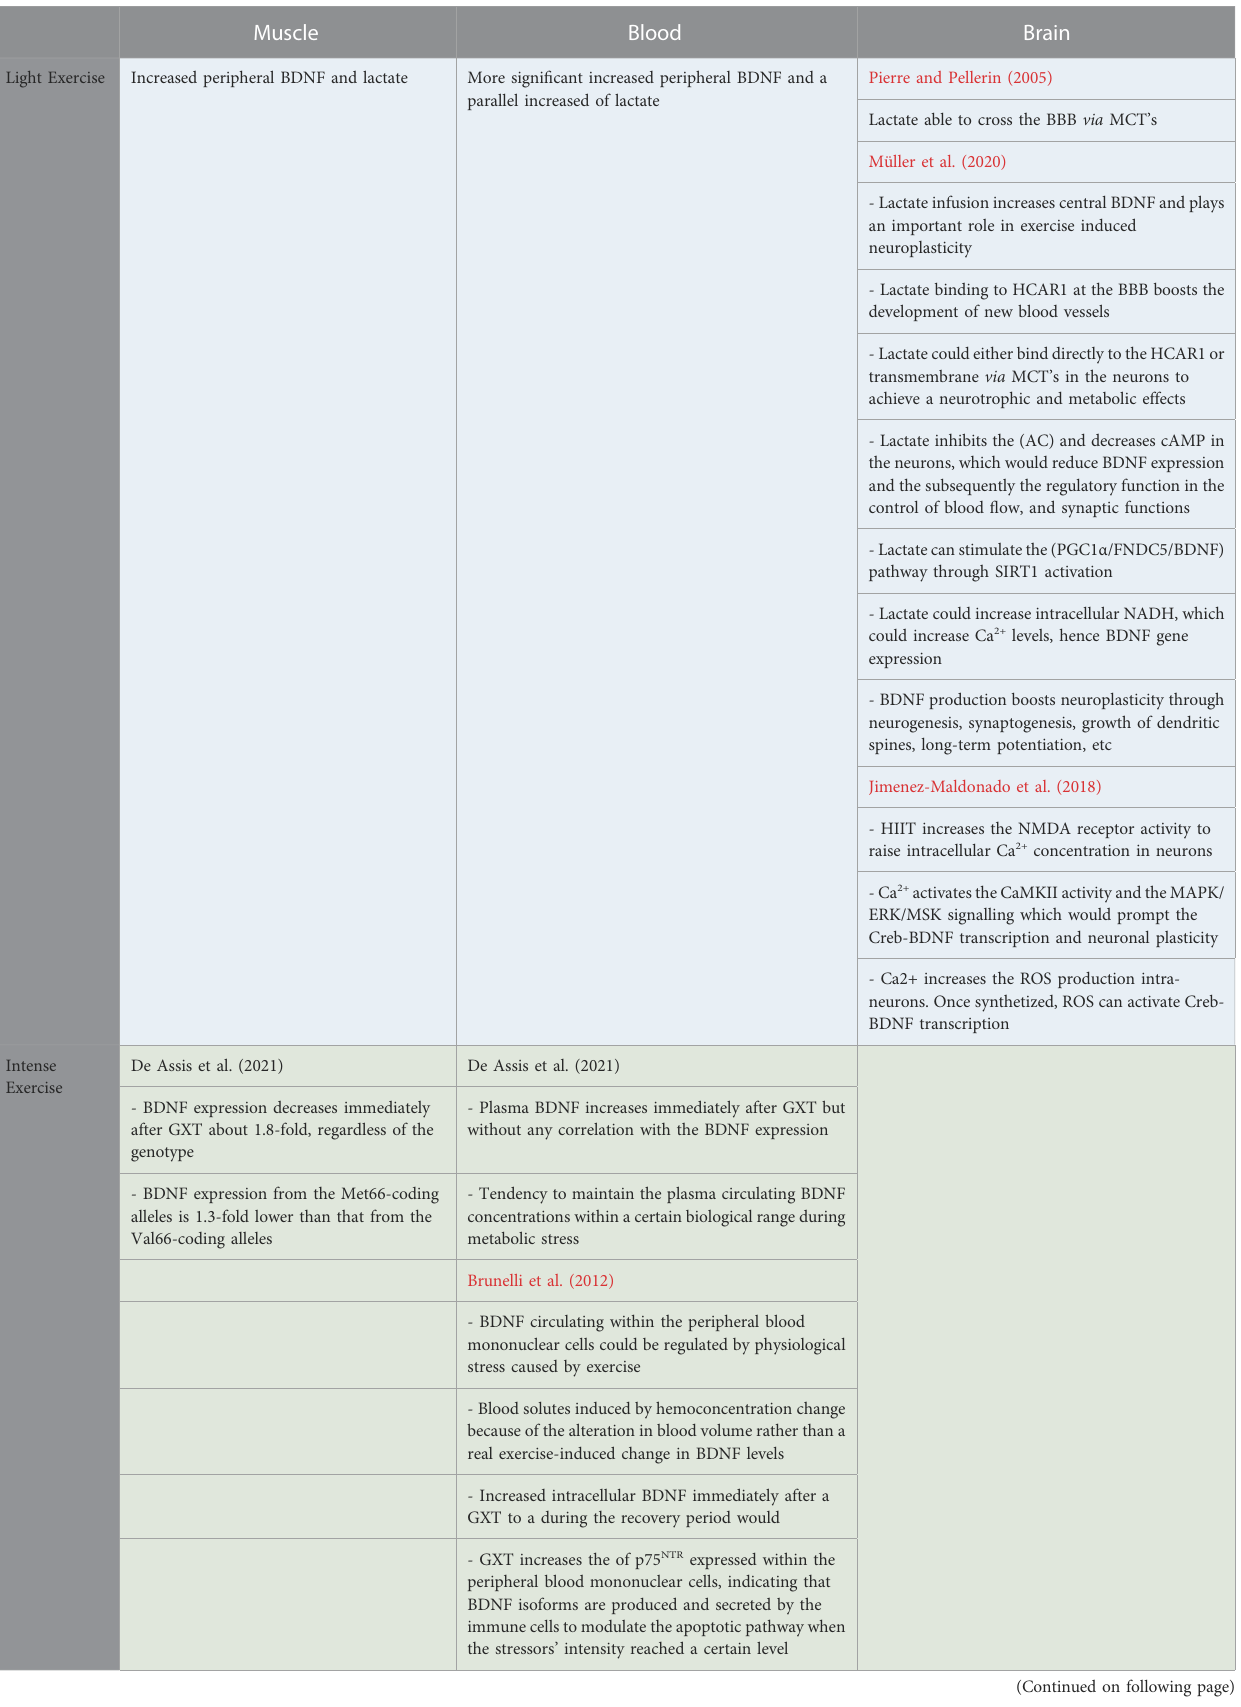
TABLE 4 Suggested physiological mechanisms underpinning BDNF